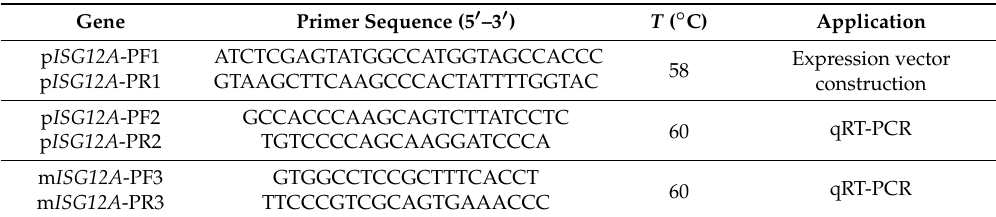
Table 1. Oligos used in the present